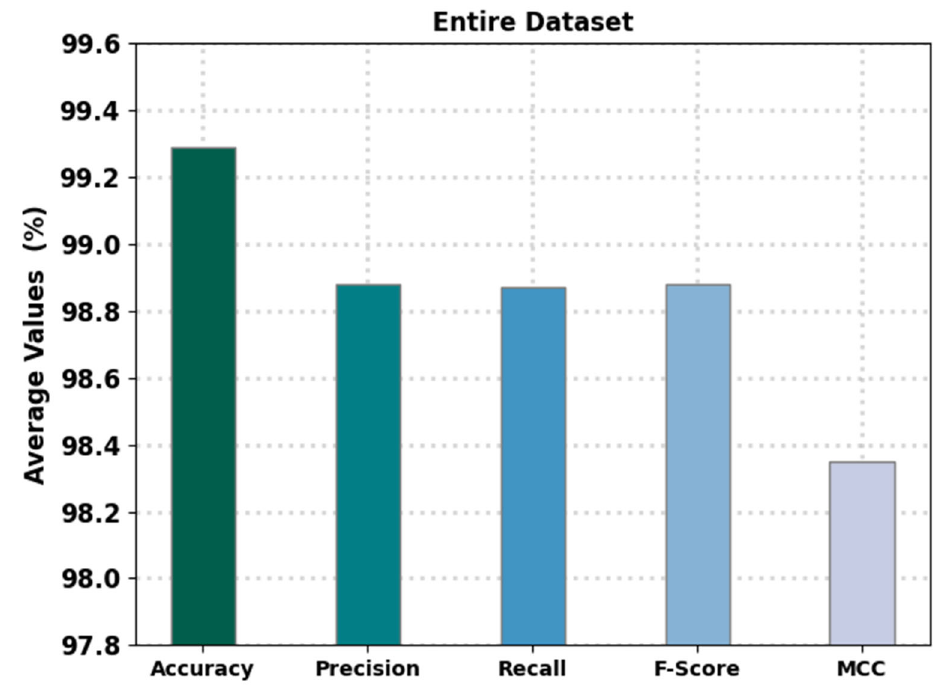
Figure 4. Average analysis of BND-BMOML algorithm using entire dataset.